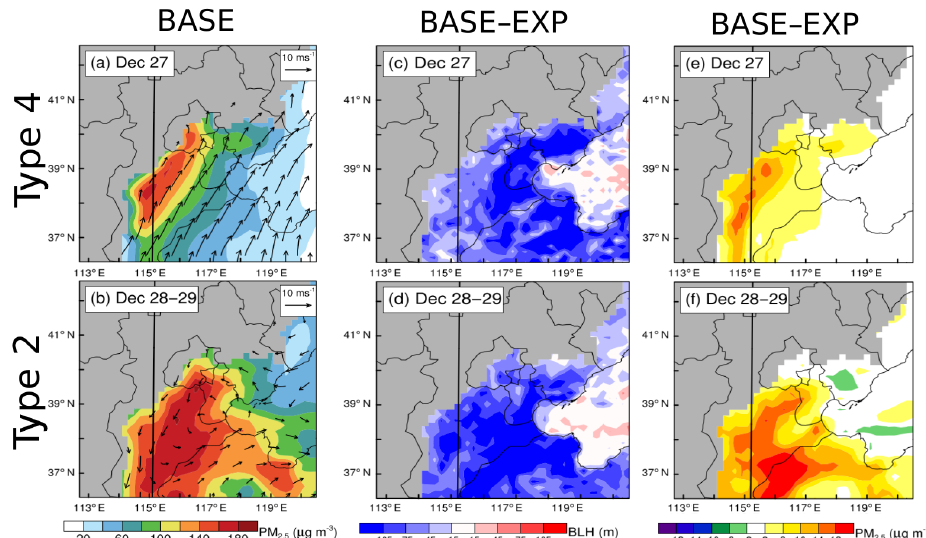
Figure 9. Spatial distribution of simulated (a, b) near-surface PM 2 . 5 concentration, wind, and the perturbations induced by the aerosol radiative effect on (c, d) BLH and (e, f) PM 2 . 5 in the plains of BTH from 09:00 to 16:00BJT on (a, c, e) 27 December and (b, d, f) 28– 29 December. The black line in Fig. 9a indicates the locations of vertical sections shown in Fig. 10.